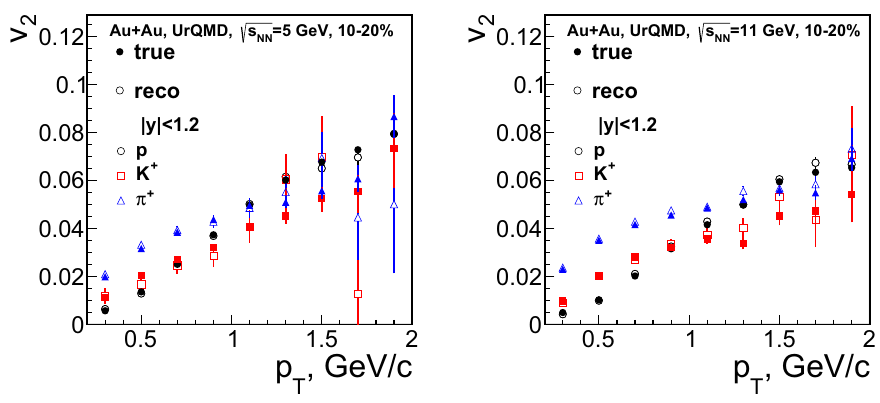
√ s = 5 (left) and 11 GeV NN